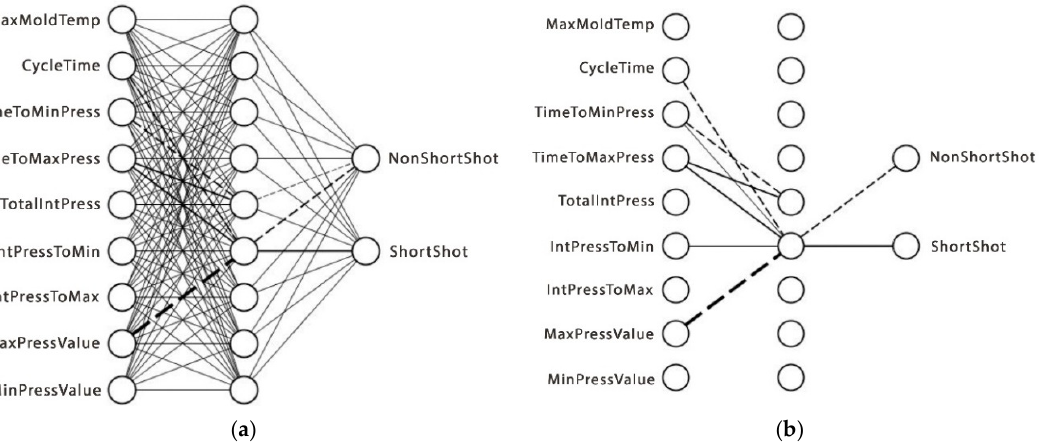
Figure 5. The ANN model after being trained using: ( a ) a backpropagation algorithm and ( b ) structural learning with the forgetting approach.